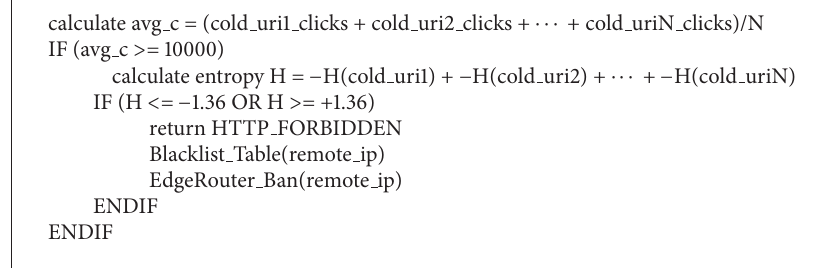
Algorithm 7: High rate attack entropy algorithm.